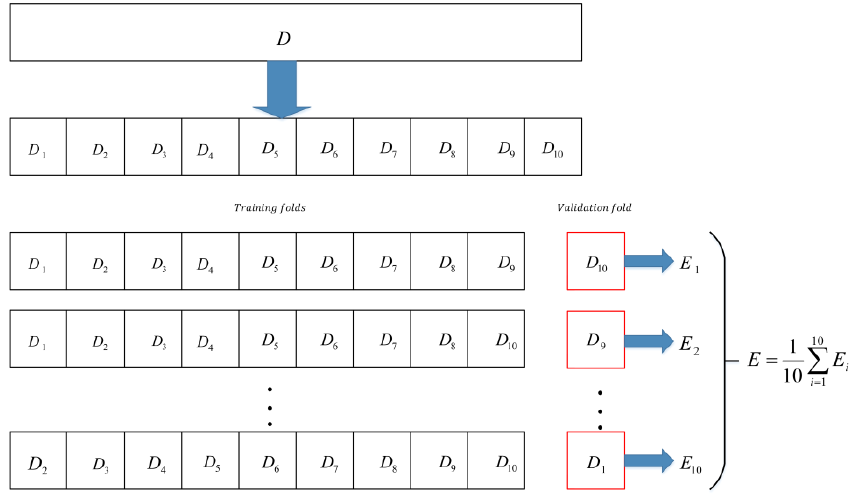
Fig 10. Schematic diagram of the ten-fold cross-validation